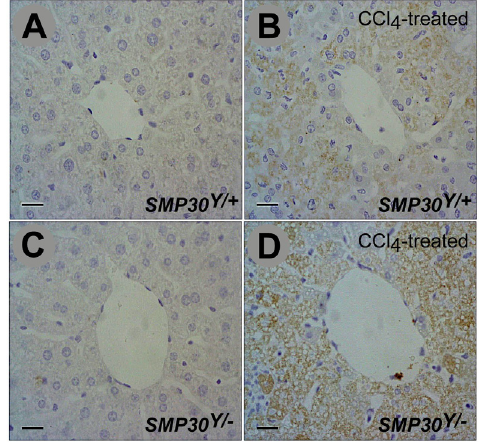
-treated SMP30 Y/+ ; 4